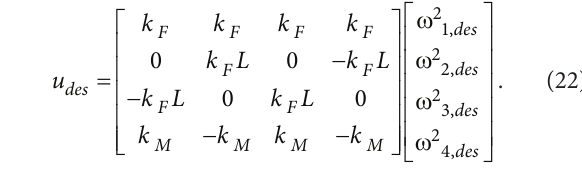
Figure 4. Nested control loops for position and attitude control (Kumar,